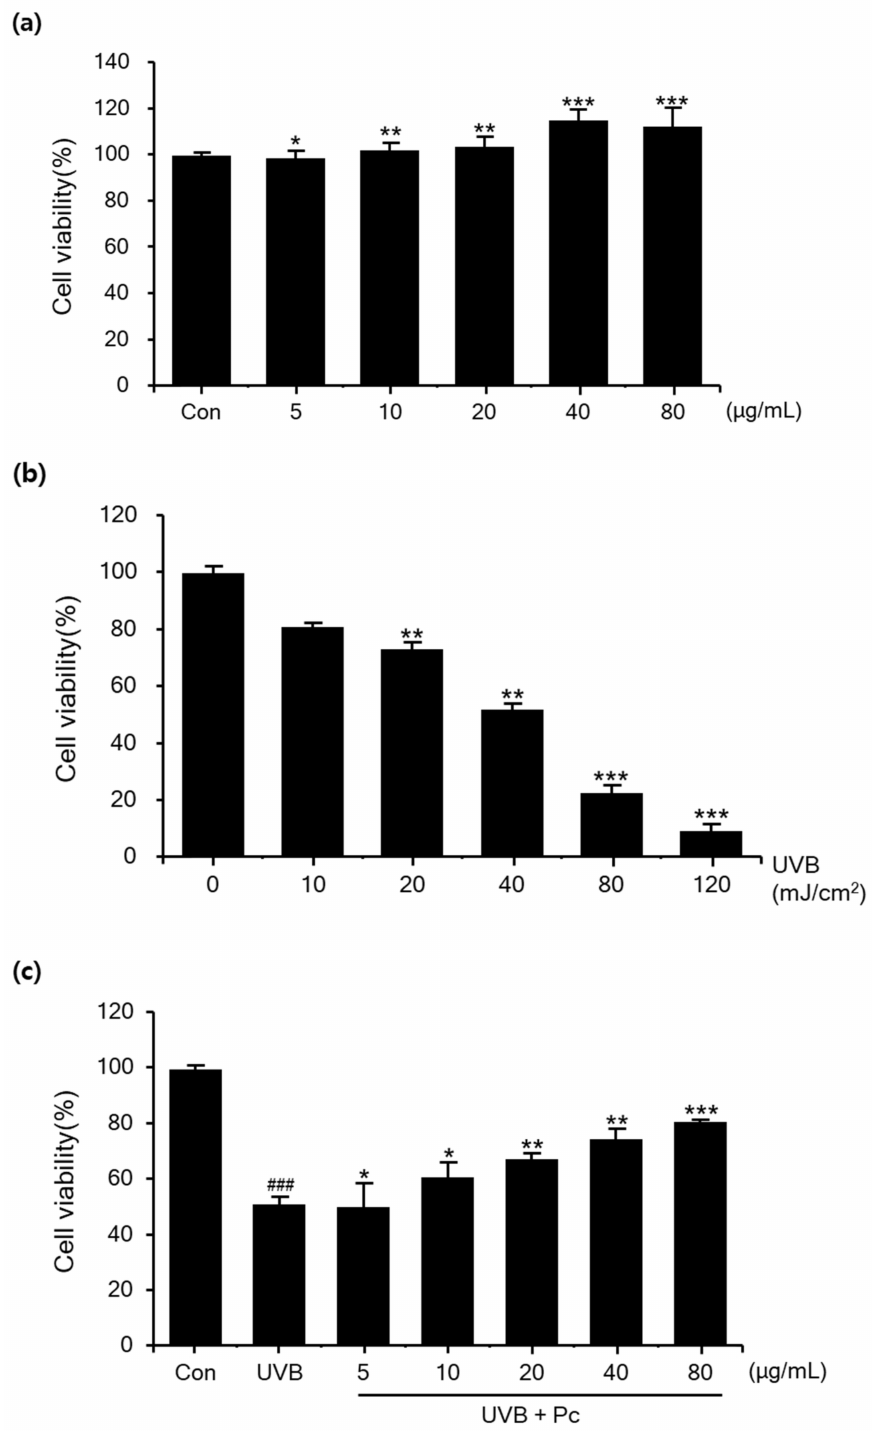
Figure 2. Cell viability of human keratinocytes after ultraviolet B (UVB) exposure. ( a ) HaCaT cell viability after pretreatment with various concentrations of C-phycocyanin (C-PC); ( b ) toxicity of UVB according to the dosage; ( c ) viability of cells treated with C-PC, followed by UVB irradiation. Data are presented as percentages of the control group. ### p < 0.001 vs. control group. * p < 0.05, ** p < 0.01, and *** p < 0.001 vs. UVB/vehicle